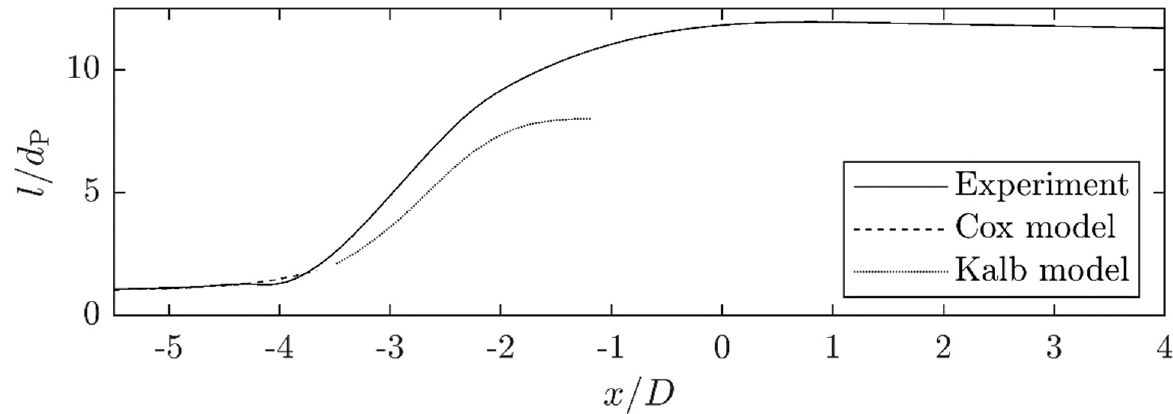
Figure 14. Comparison of the drop aspect ratio development when passing through the orifice between the exper- imental measurement and the numerical simulation according to the Cox or Kalb model for a low viscosity drop ( λ exp = 0.3/ λ num = 0.29) at a Reynolds number of Re = 2000.